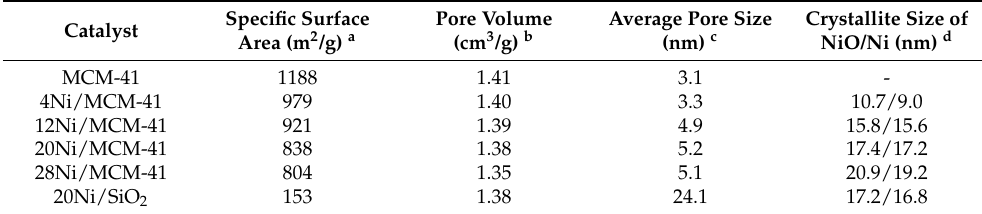
Figure 4. Wide-angle XRD patterns of the ( a ) calcined samples and ( b ) reduced samples, and ( c ) small-angle XRD patterns of calcined samples. Table 1. Textural properties and crystallite sizes of various